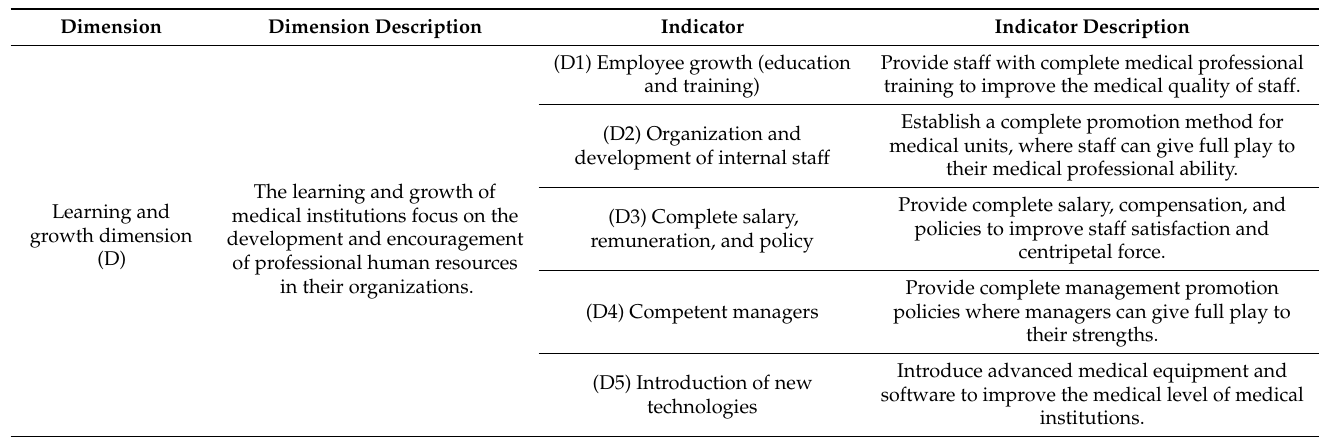
Table 1. Cont. Dimension Dimension Description Indicator Indicator Description